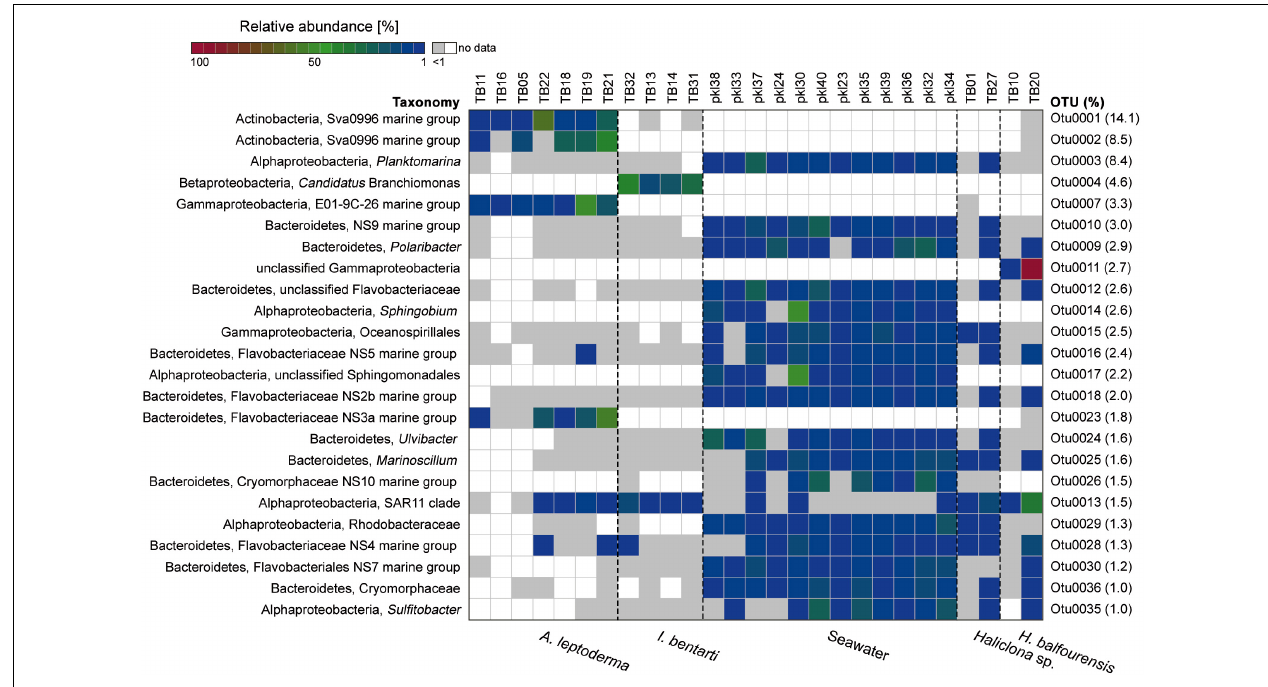
FIGURE 3 | Relative abundance heatmap of the 24 most abundant (i.e., with > 1600 reads or 1% relative abundance among all OTUs based on the sum of all available reads) 16S rRNA gene OTUs. The corresponding relative abundance of each OTU among all available OTUs is given on the right side, whereas the colorization depicts the sum of reads per individual OTU. The taxonomy consists of the highest and lowest available taxonomic rank available for each OTU. Low abundance occurrences of OTUs per sample ( < 1%) are colored in light gray. Samples are sorted using the cluster analysis shown in Figure 2